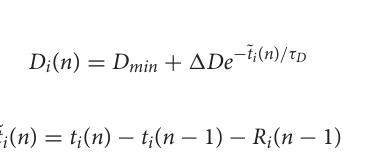
FIGURE 1 | A schematic representation of the proposed model. The arrow indicates the direction an impulse can conduct, and the colors represent nodes with the same parameter sets. For simplicity, only a subset of the ten nodes in each pathway are